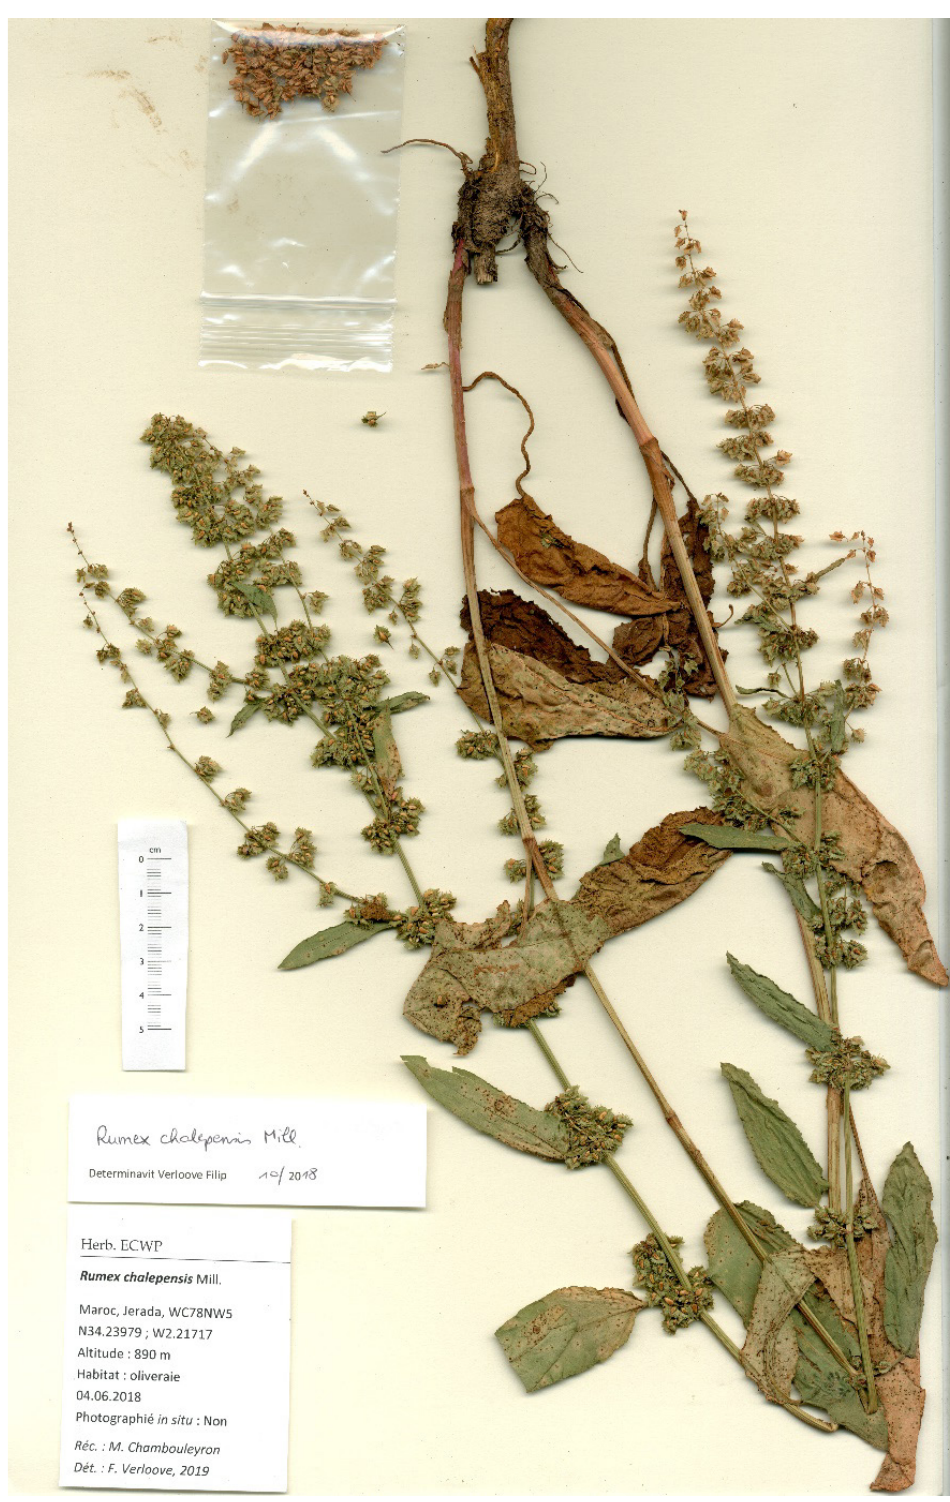
Figure 1. Herbarium specimen of Rumex chalepensis from Morocco (herb. ECWP